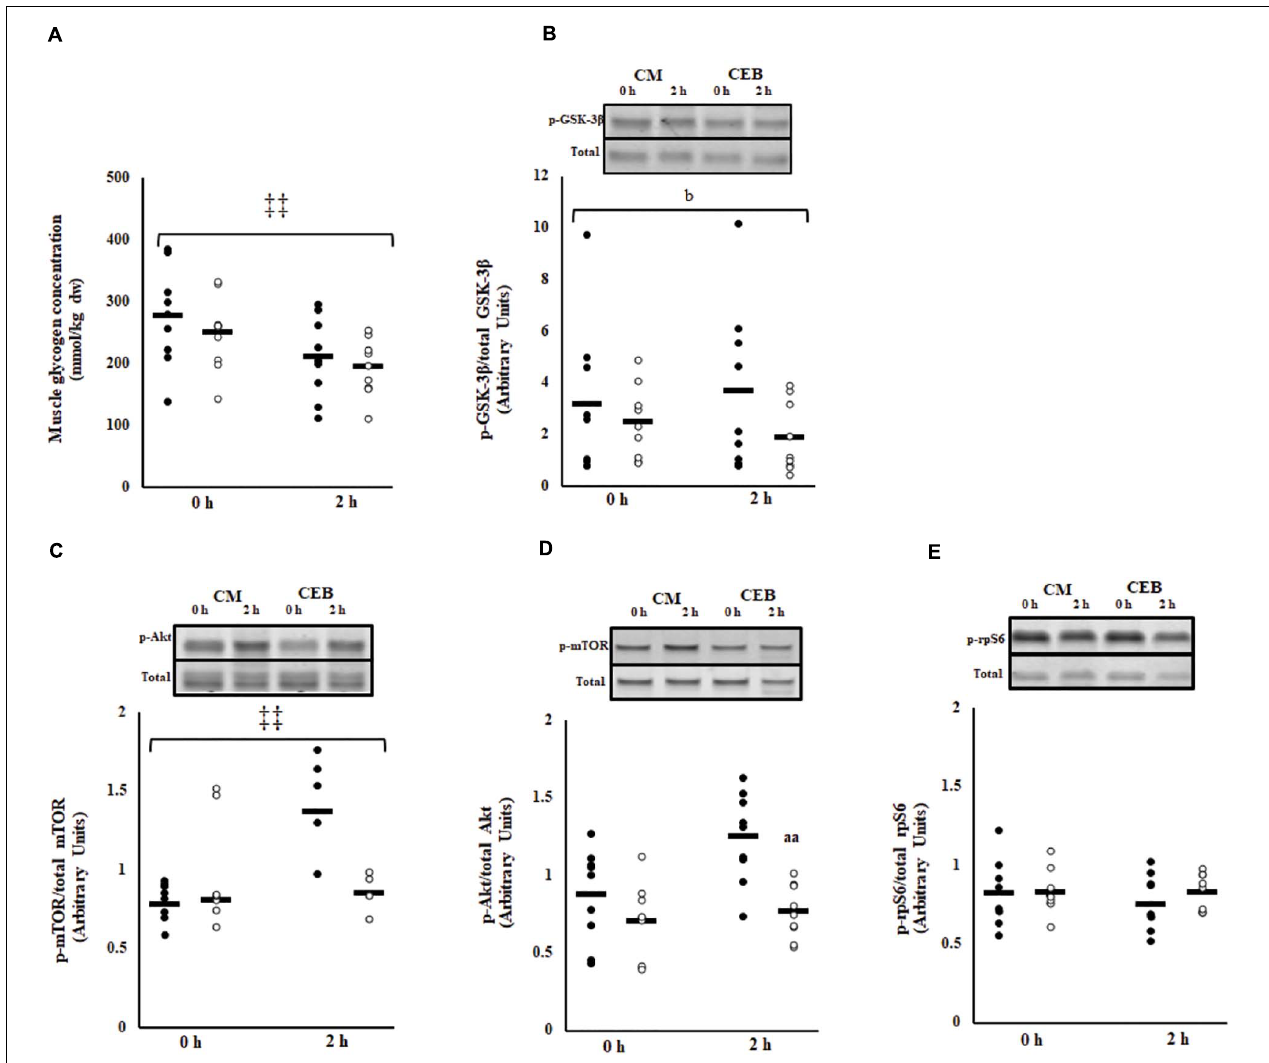
FIGURE 5 | Muscle glycogen content (A) , phosphorylated GSK3- β to total GSK3- β (B) , ratio of phosphorylated mTOR to total mTOR (C) , phosphorylated Akt to total Akt (D) , and phosphorylated rpS6 to total rpS6 (E) after 2 h HIIT exercise in temperate ambient conditions and consumption of a chocolate dairy milk (CM: (cid:4) ) or the carbohydrate-electrolyte